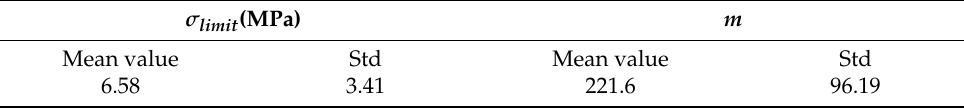
Table 5. Exponential law fitting